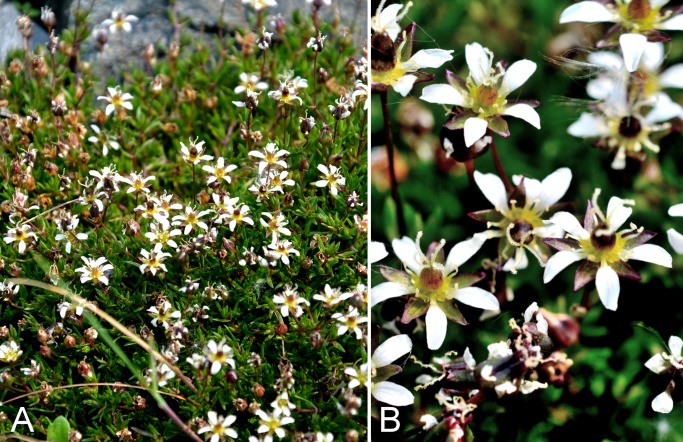
Sabulina elegans.(A) Habit, Saarela et al. 4328. (B) Inflorescence, Saarela et al. 4328. Photographs by P. C. Sokoloff.